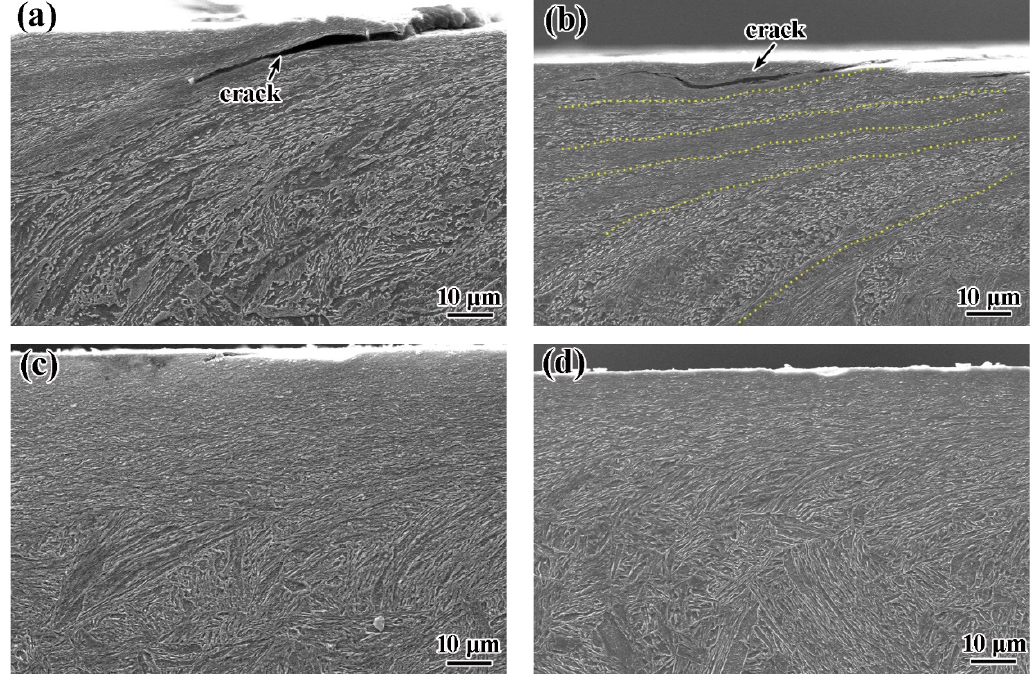
Figure 11. Microstructure of the longitudinal section of the 1280 G and 1380 G rail steels under different rolling cycles. ( a ) 1280 G after 1 × 10 4 cycles; ( b ) 1280 G after 7.5 × 10 4 cycles, where yellow dashed lines show the uneven deformation of segregation bands; ( c ) 1380 G after 1 × 10 4 cycles; ( d ) 1380G after 7.5 × 10 4 cycles.